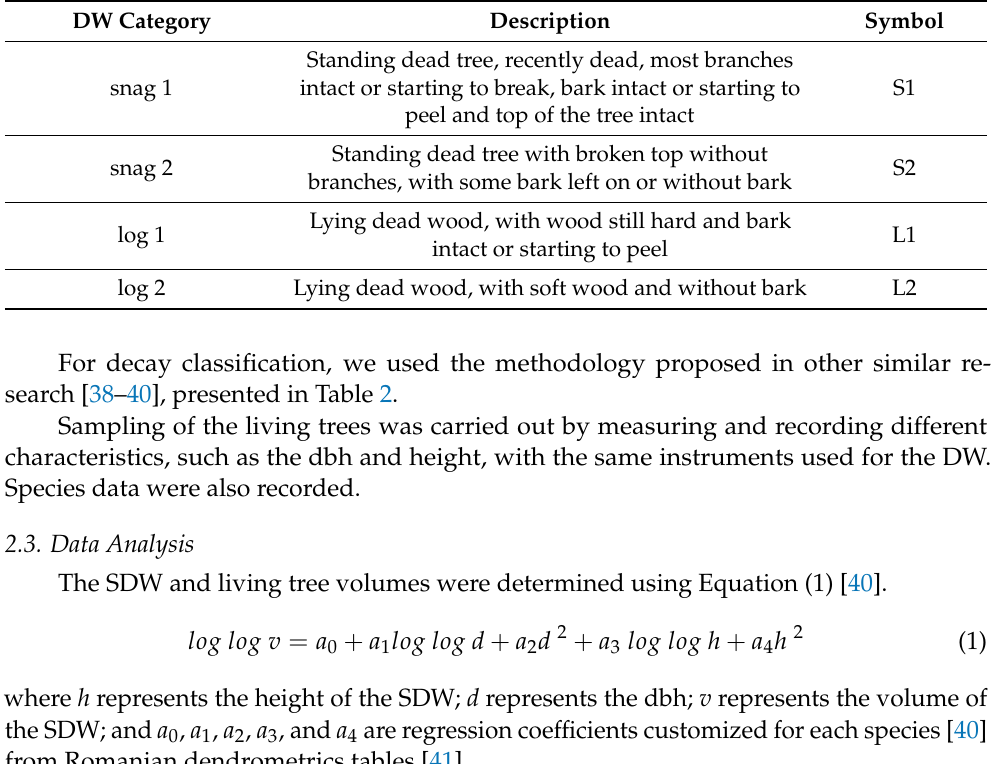
Table 2. Dead wood categories depending on decay stages. DW Category Standing dead tree, recently dead, most branches snag 1 intact or starting to break, bark intact or starting to peel and top of the tree intact Standing dead tree with broken top without snag 2 branches, with some bark left on or without bark Lying dead wood, with wood still hard and bark log 1 intact or starting to peel log 2 Lying dead wood, with soft wood and without bark